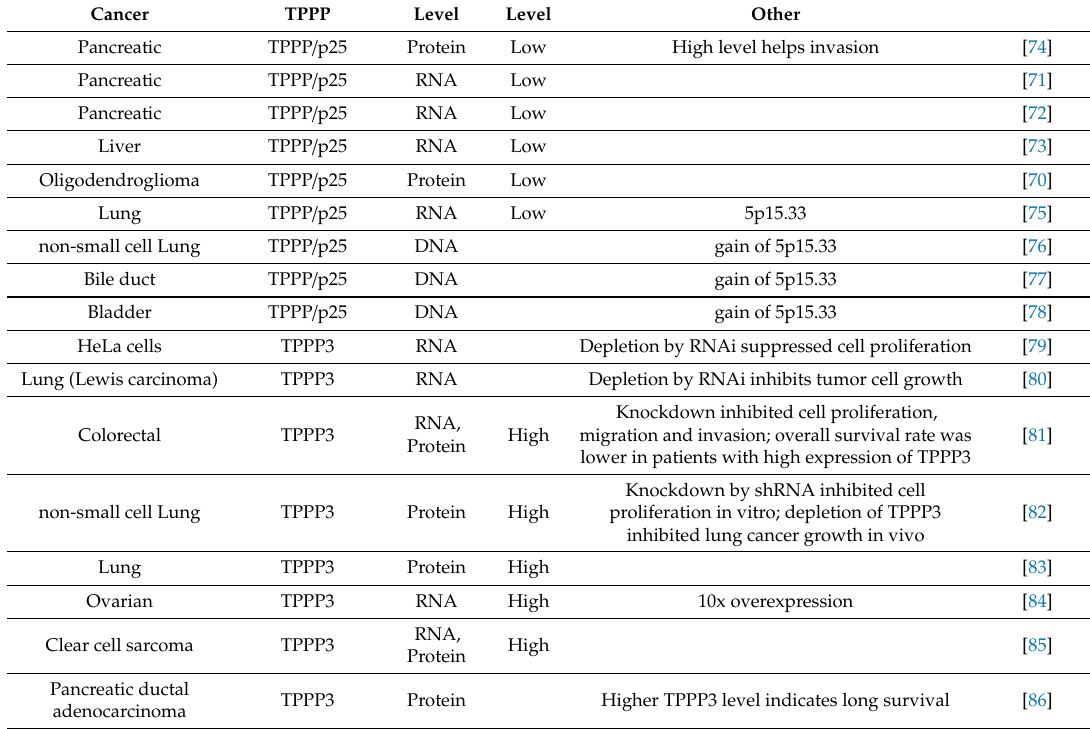
Table 1. TPPPs in